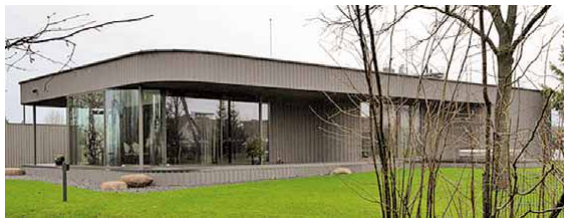
Fig. 13. House in Domeikava, Kaunas, archit. V.